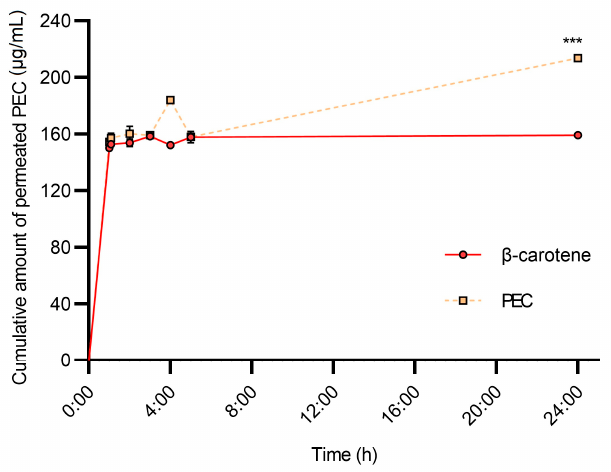
Figure 6. Cumulative amount (µg/mL) of permeated persimmon extract rich in carotenoids (PEC) through Franz diffusion cells synthetic skin membranes model. PEC carotenoids permeated significantly more than the control β -carotene after 24 h of exposure (*** p < 0.001, ANOVA, and t -test post hoc).